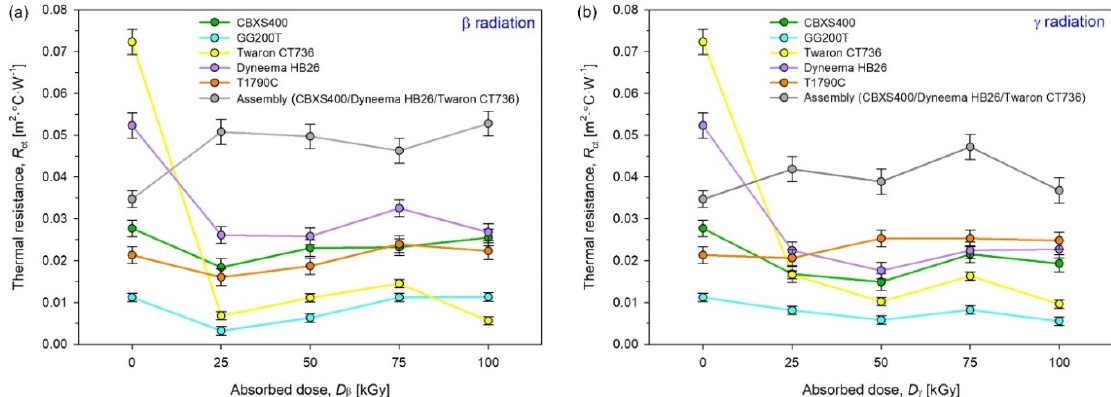
Figure 14. Thermal resistance of unmodified and irradiated textiles using ( a ) β-radiation, ( b ) γ- Figure 14. radiation (lines guide the eye). ( b ) γ -radiation (lines guide the